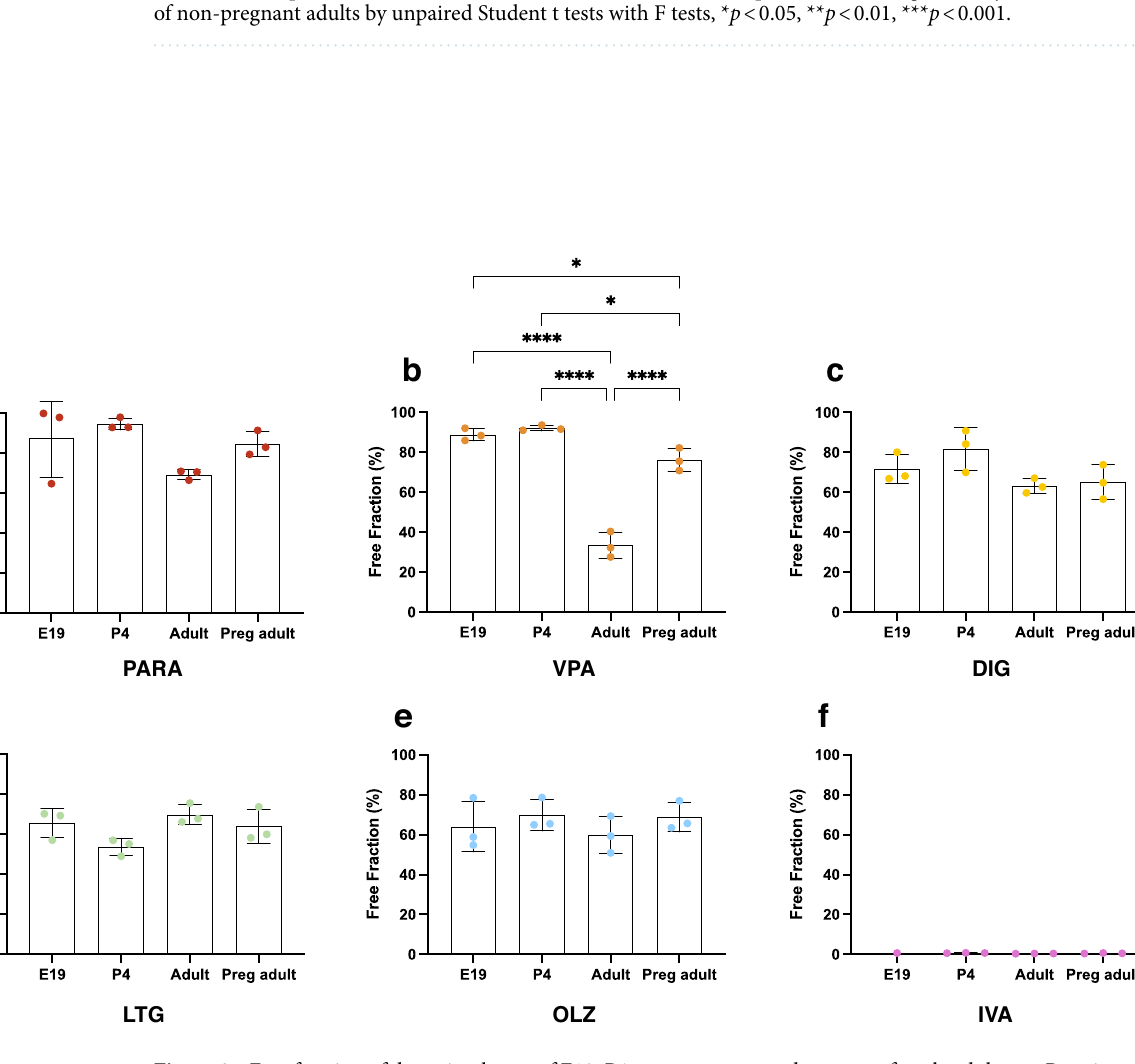
Figure 2. Free fraction of drugs in plasma of E19, P4, non-pregnant and pregnant female adult rats. Protein- free fraction/whole plasma concentration ratios (%) in plasma of E19, P4, non-pregnant and pregnant female adult rats spiked with ( a ) paracetamol (PARA), ( b ) valproate (VPA), ( c ) digoxin (DIG), ( d ) lamotrigine (LTG), ( e ) olanzapine (OLZ), or ( f ) ivacaftor (IVA) with respective [ 3 H]-labelled drugs. Mean ± SD where appropriate; n = 1–3. One-way ANOVA with Tukey’s multiple comparisons; * p < 0.05, **** p <